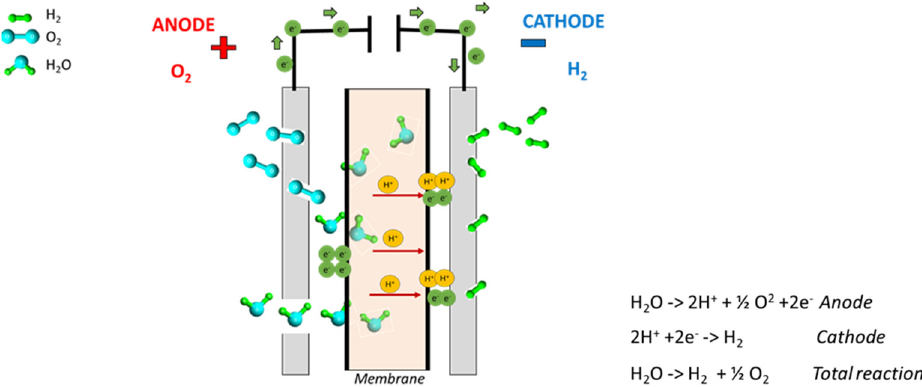
Figure 1. Working principle of a PEM